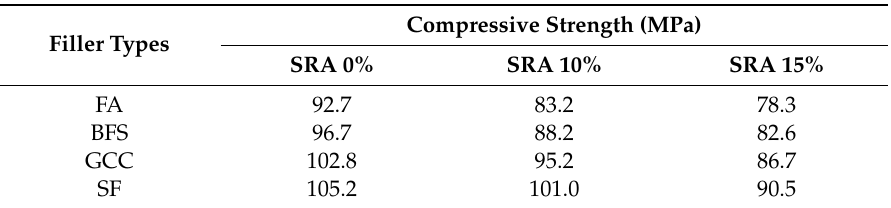
Table 11. Compressive strengths by SRA content and filler